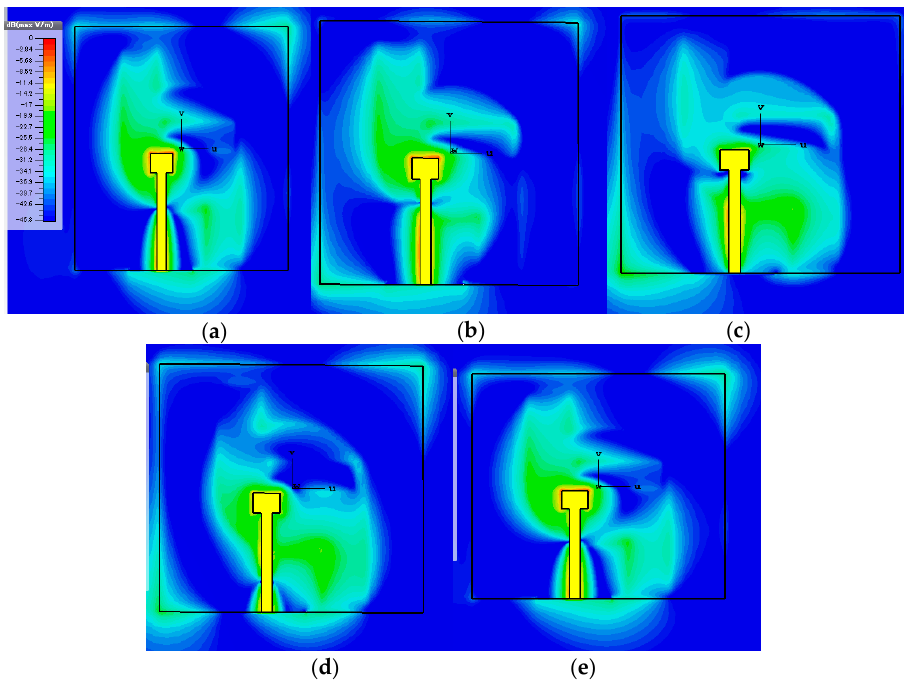
Figure 7. Electric field distribution at a frequency of 2.2 GHz at: ( a ) 0, ( b ) 45, ( c ) 90, ( d ) 135, and ( e ) 180 degrees.